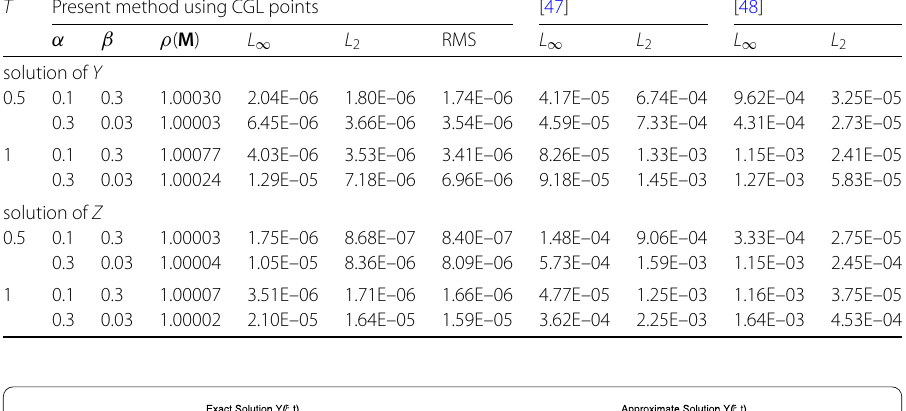
Table 10 Error norms and spectral radius for Y ( ξ , t ) and Z ( ξ , t ) of Example 5 for dt = 0.001 T Present method using CGL points [47] [48] α β ρ ( M ) L ∞ L 2 L 2 L ∞ L 2 solution of Y 0.5